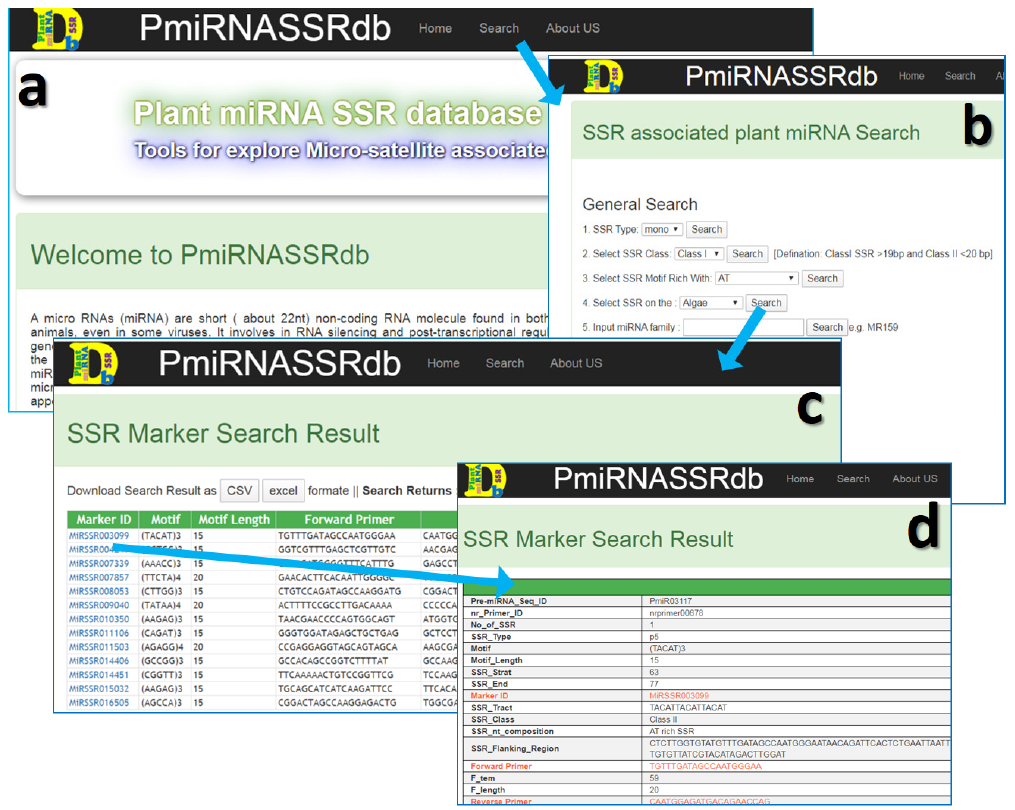
Figure 5. Flow of a search in PmiRNASSRdb (plant microRNA simple sequence repeat database). ( a ) Home page, ( b ) marker search interface, ( c ) query result, and ( d ) detailed information on each marker.